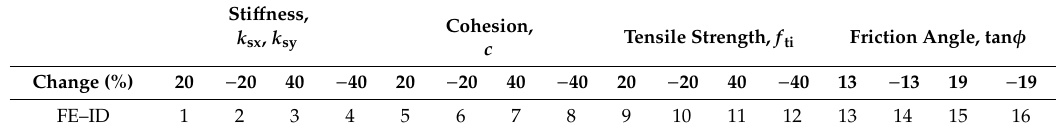
Table 3. Material parameters for FE sensitivity study and corresponding FE model IDs.